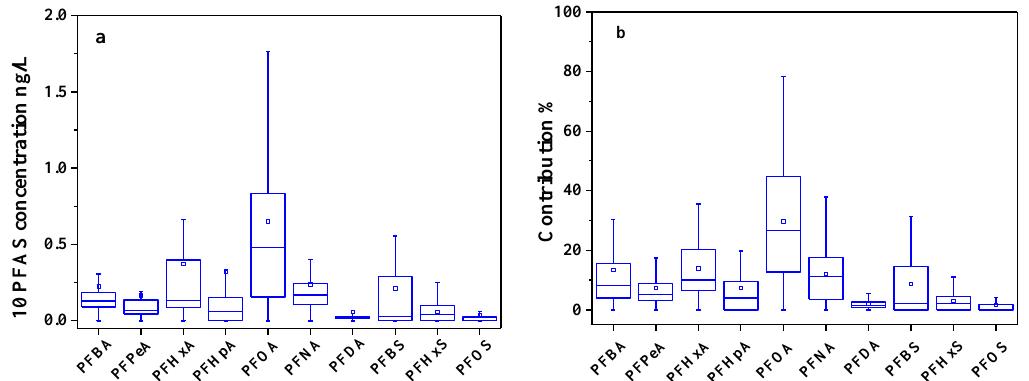
Figure 3. Concentrations of PFAS ( a ) and their contributions ( b ) in groundwater samples from APPHR in Shijiazhuang City.